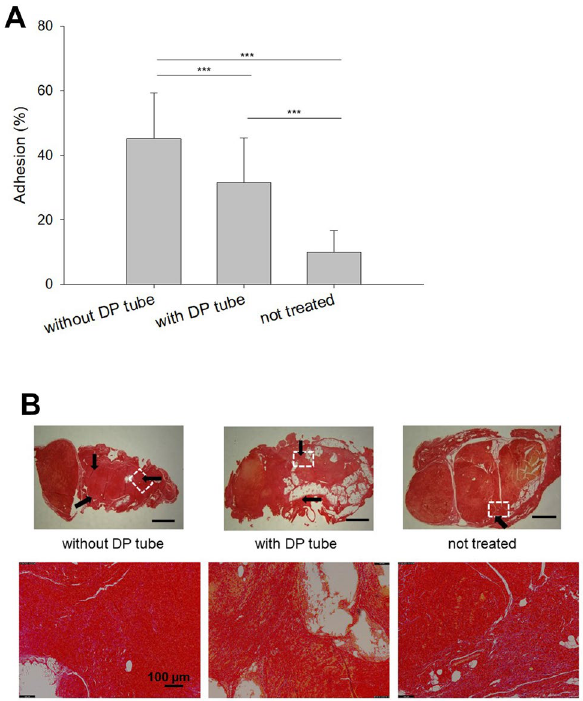
Figure 2. Adhesion formation as assessed by histology via contact region to the surrounding tissue. Adhesions were determined at 12 weeks. Quantitative determination: percentage of contact region ( A ); typical Picosirius Red stained cross-sections, including white dashed areas that are magnified below each image ( B ). Key : DP = DegraPol. Stars, with p-values, indicate pairwise comparison probability: p < 0.05 (*), p < 0.01 (**) and p < 0.001 (***). Scale bars indicate 500 µm. Arrows depict areas of adhesion (contact to surrounding